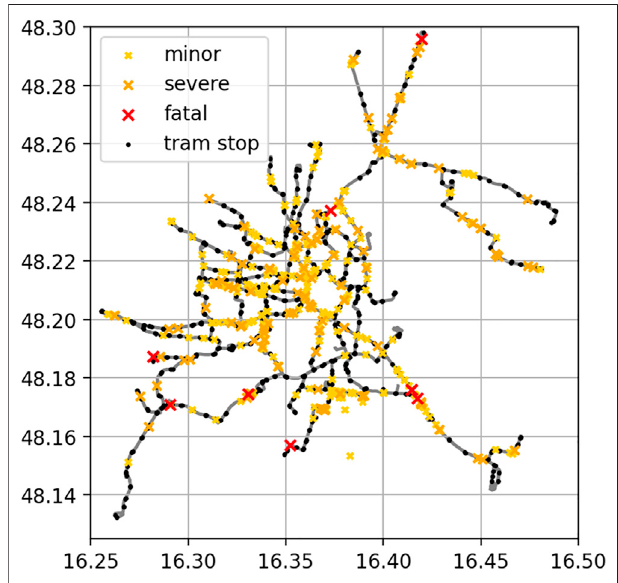
FIGURE 1 | Vienna OSM tram track network, with the associated 933 tram stops and the location of